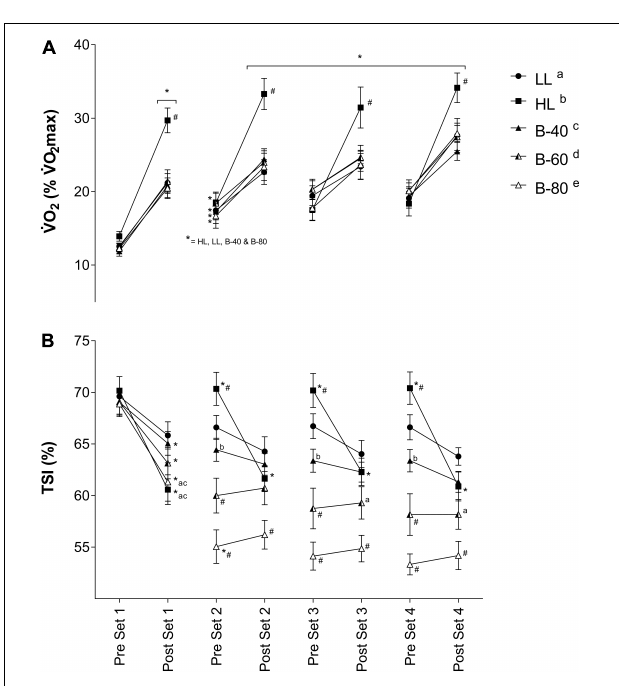
FIGURE 4 | (A) Whole body volume of oxygen consumption (˙VO 2 ) and (B) Muscle oxygenation (TSI) of the Vastus Lateralis muscle during all five trials [heavy load (HL), light load (LL), 40% limb occlusion pressure (B-40), 60% limb occlusion pressure (B-60), 80% limb occlusion pressure (B-80)]. Values